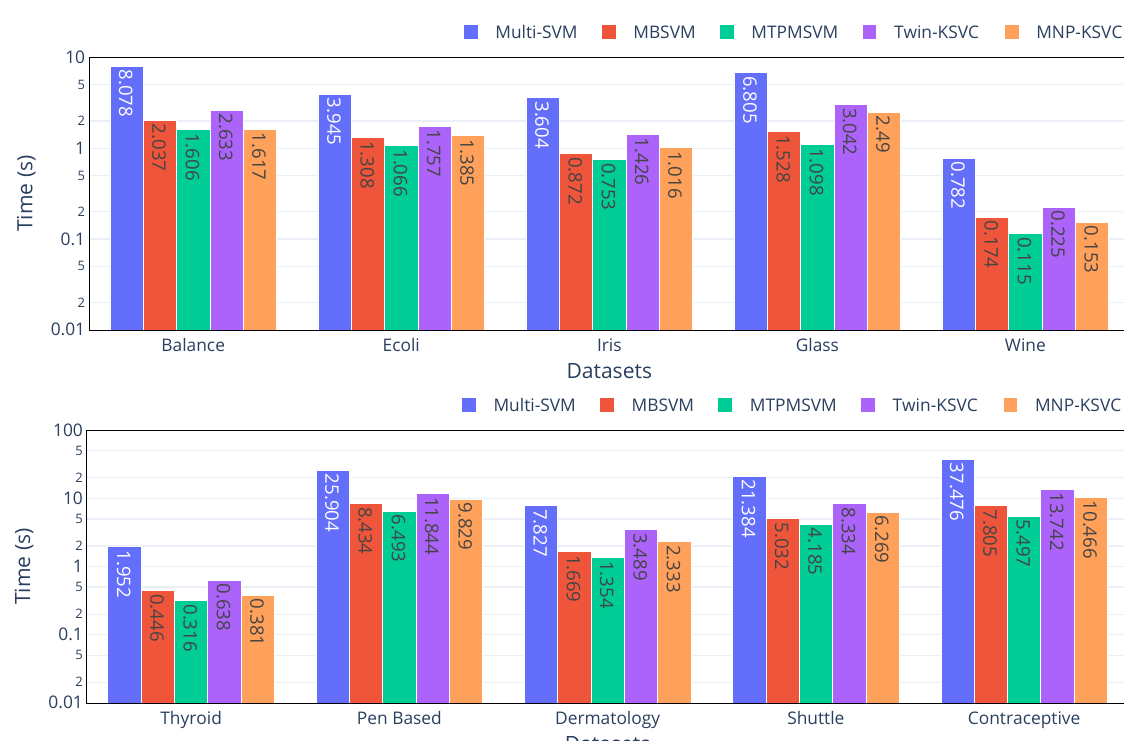
Figure 3. The learning times on benchmark datasets for nonlinear